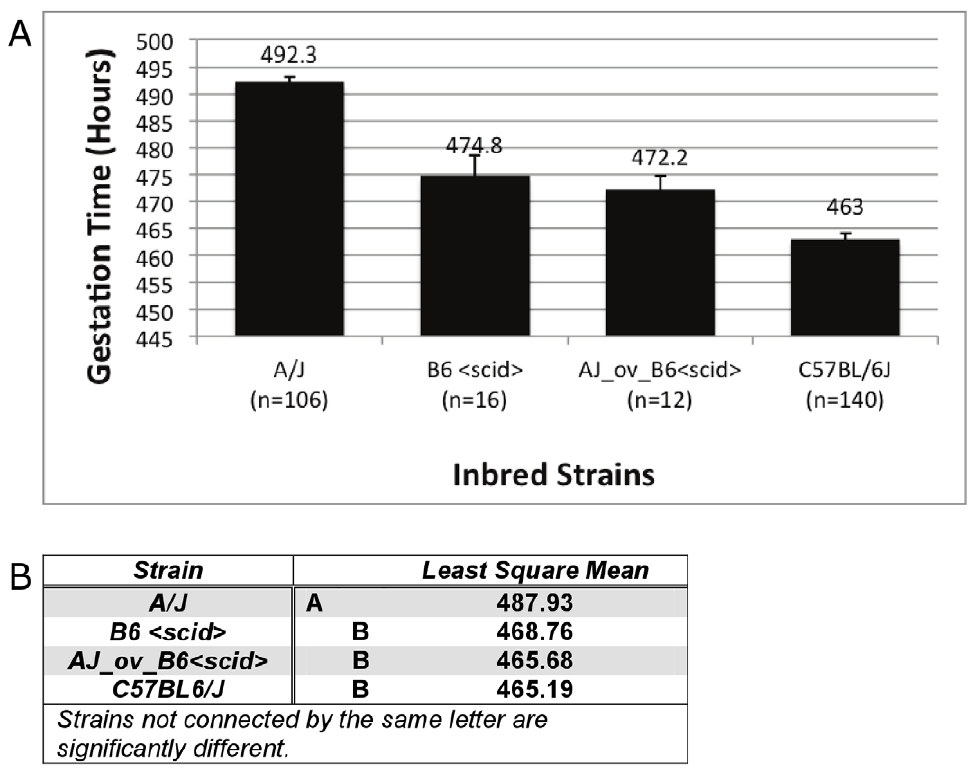
Figure 2. Gestation length is primarily dependent upon maternal genotype. (A) Gestation length presented in hours of C57BL/6J, A/J, B6.CB17- Prkdc scid /SzJ (B6- scid ), and B6-scid with transplanted A/J ovaries (AJ-ov-B6- scid ). In order to directly compare the effect of pure B6 and A/J pups in a B6 maternal background, B6- scid mice were sham manipulated and mated to B6-scid males, while AJ-ov-B6- scid females were mated to A/J males following recovery from ovary transplant (see materials and methods for details). (B) Graphical representation of strains with significantly different GLs independent of all other factors. Strains that are not associated by a letter are significantly different from each other (p , 0.05), demonstrating that B6 females show no statistical difference in gestation time, regardless of the genotype of the pups.